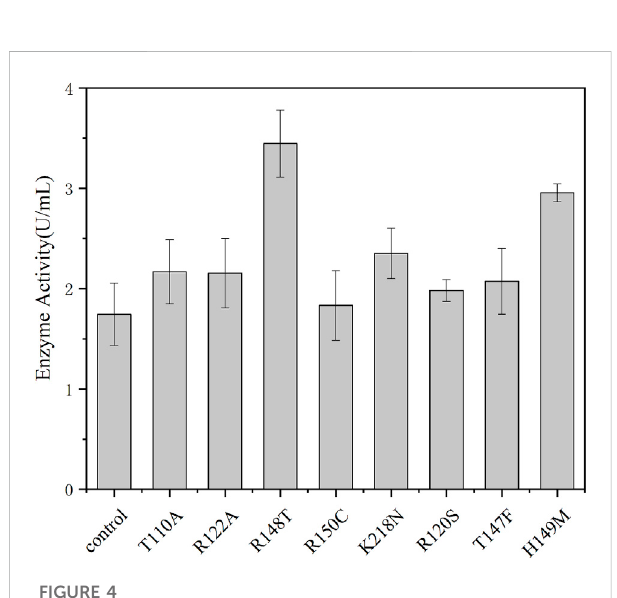
FIGURE 4 Enzyme activity of the EcNudc and its mutants under the standard reaction condition (37 ° C, pH 8.0).